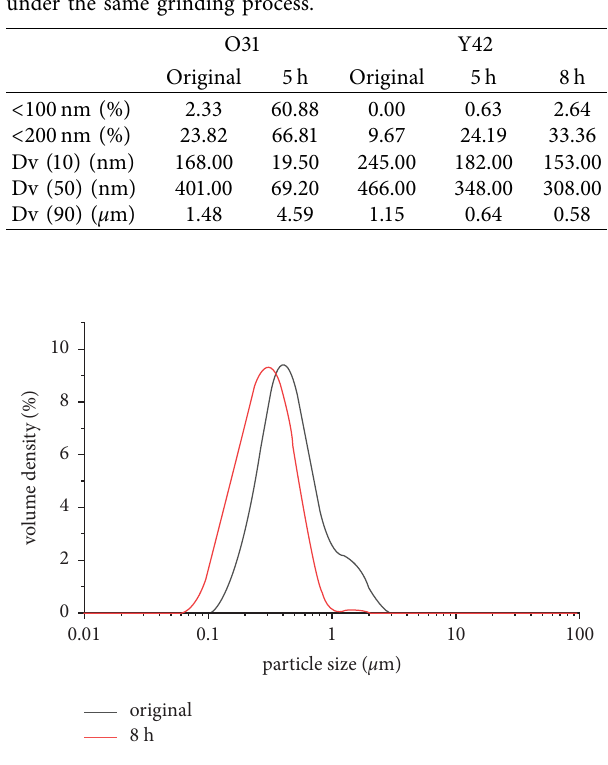
Figure 4: Particle size distributions of the original disperse yellow 42 sample after grinding for 8